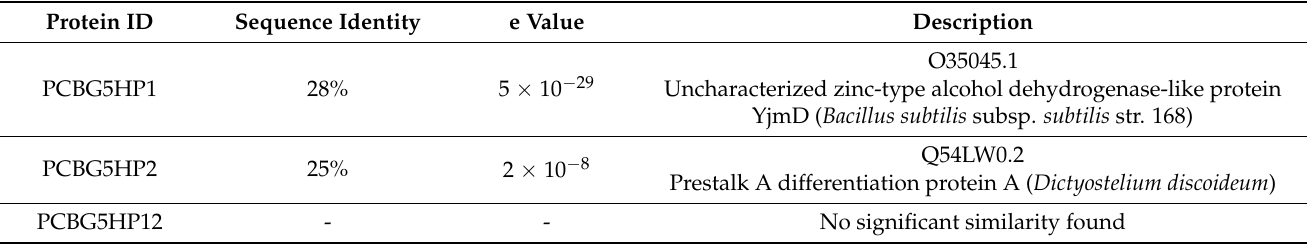
Table 3. The BLAST search results for the selected HPs from P. cryoconitis against the NCBI non- redundant UniProtKB/SwissProt sequences database.